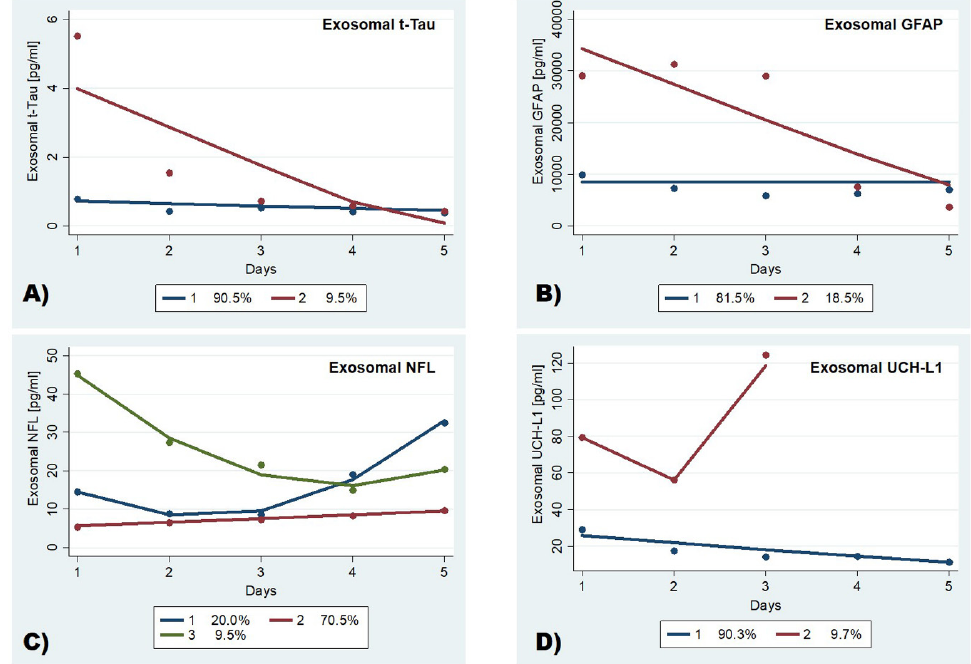
Figure 4. Trajectories of exosomal ( A ) t-tau, ( B ) GFAP, ( C ) NFL, and ( D ) UCH-L1. The group-based trajectory analysis procedure identified three groups for exosomal NFL, and two groups for exosomal t-tau, GFAP, and UCH-L1. Percent membership for each trajectory group is indicated. Table 3. Sensitivity and specificity of two-group exosomal UCH-L1 model for predicting early mortality.